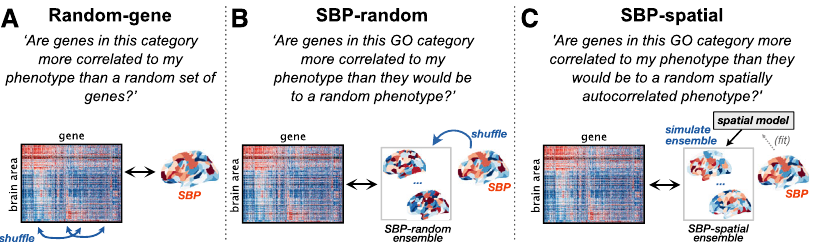
Fig. 4 The statistical signi fi cance of a GO category can be quanti fi ed relative to conventional random-gene nulls, or ensemble-based null models introduced here. For a given spatial brain phenotype (SBP) of interest, we depict the process through which null samples are generated for estimating statistical signi fi cance for GCEA across three different null models. A The conventional random-gene null tests whether the observed result is more extreme than if genes were assigned to GO categories at random (similar to the illustrated shuf fl ing of gene identities). As this destroys within-category gene – gene correlation structure, it leads to high category false-positive rates for random phenotypes. An alternative is to compute null distributions for each category based on an ensemble of null phenotypes. B The SBP-random null tests whether the observed result is more extreme than if the phenotype of interest was a random spatial map. C The SBP-spatial null tests whether the observed result is more extreme than if the phenotype of interest was a random spatially autocorrelated